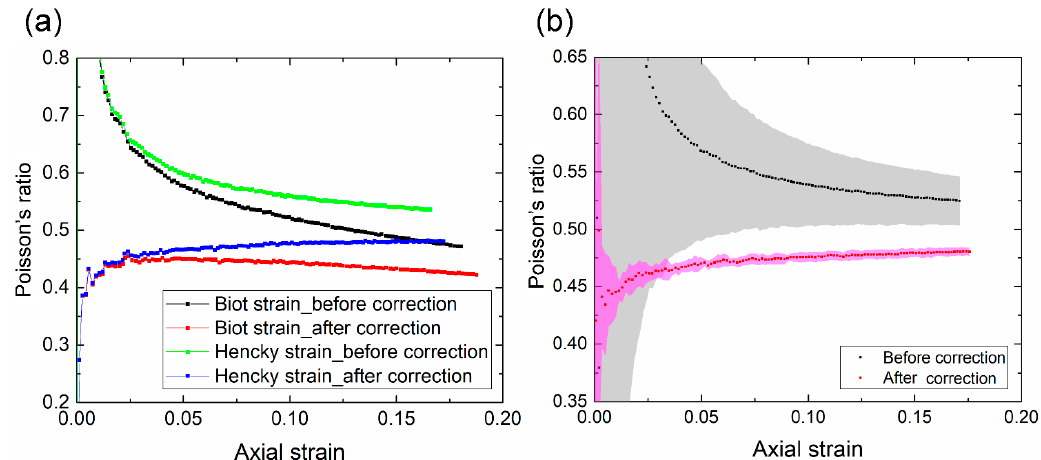
Figure 5. ( a ) Comparison of the Poisson’s ratios determined by Biot and Hencky strains before and after the correction for the first loading. ( b ) Means and standard deviations of the Poisson’s ratio (Hencky form). The results are based on six samples at a loading rate of 10 mm/min.